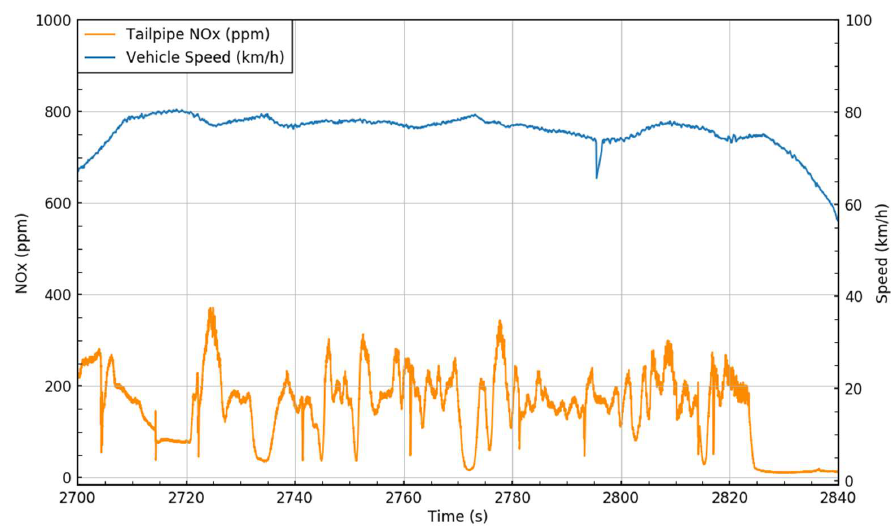
Figure 15. NO x emissions from the EUV bus at high speeds on the A34.